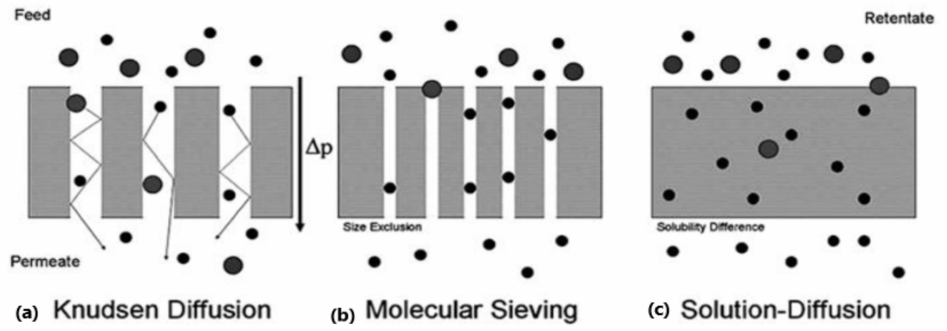
Figure 10. Gas permeation mechanism: ( a ) Knudsen-diffusion mechanism; ( b ) molecular-sieving mechanism; ( c ) solution- diffusion mechanism [95]. Adapted from [95].